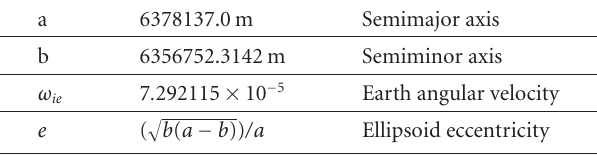
Table 1: Definition of the parameters for WGS84 reference